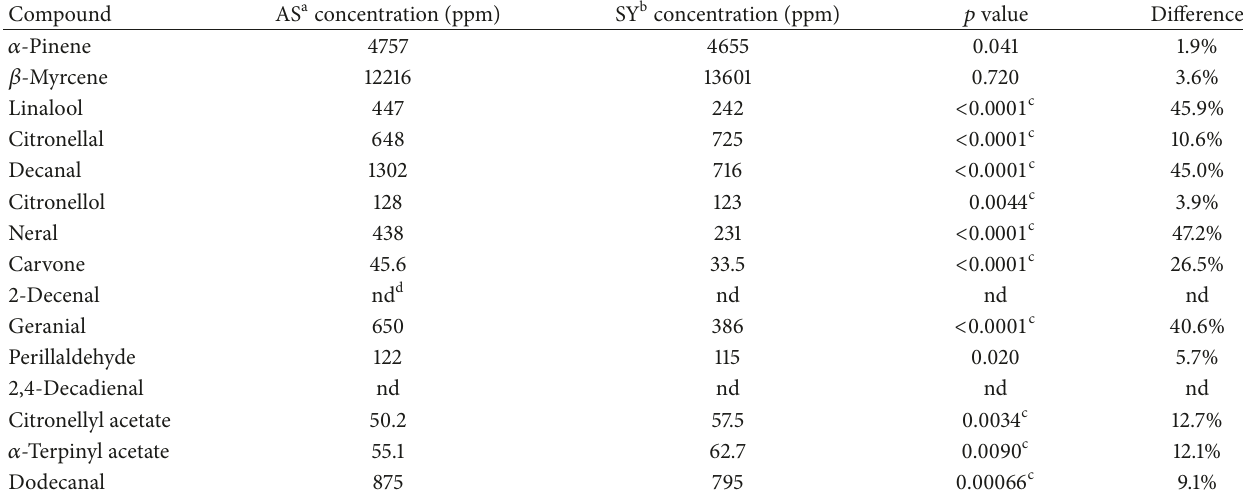
Table 4: Hamlin late asymptomatic versus symptomatic compound concentration.